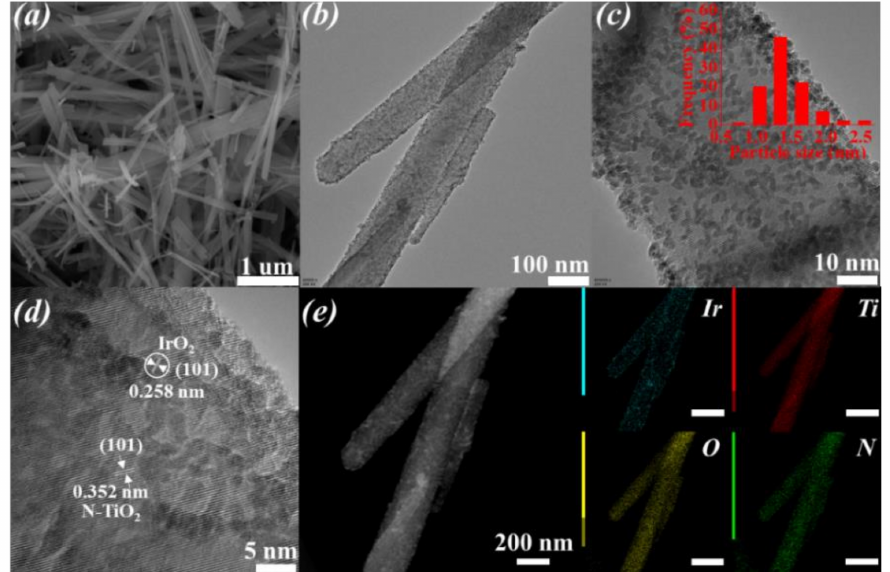
Figure 2. ( a ) SEM image; ( b ) TEM; ( c , d ) HR–TEM; ( e ) HAADF image; and the corresponding EDX mapping of Ir, Ti, O, and N elements of IrO 2 /N–TiO 2